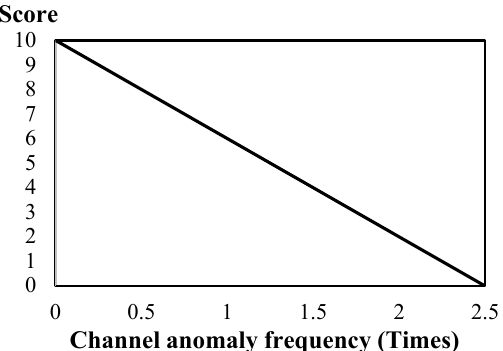
Figure 5. Channel operation scoring criteria.